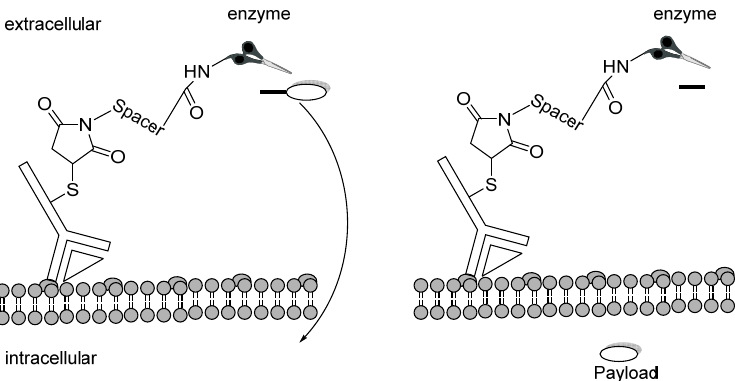
Figure 3. Antibody – enzyme conjugate bound to antigens on the surface of malignant cells.